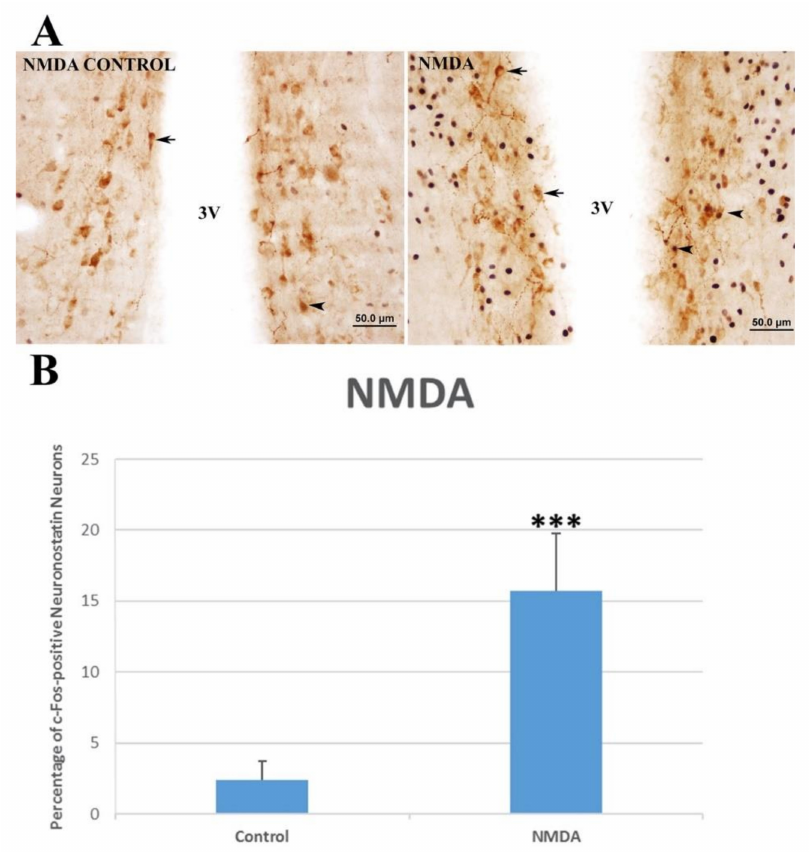
Brain Sci. 2020 , 10 , x FOR PEER REVIEW 7 of 14 neuronostatin neurons after 48 h fasting (on the left), pSTAT5 expression in neuronostatin neurons activated with refeeding in anterior hypothalamic periventricular nucleus (in the middle), neuronostatin neurons in the anterior periventricular nucleus in CNQX-treated subjects before Figure 6. The e ff ect of NMDA administration on c-Fos expression in neuronostatin neurons located in feeding (on the right) ( A ). pSTAT5 protein-expressing neuronostatin neurons ( ▲ ) and pSTAT5- the anterior hypothalamic periventricular nucleus. c-Fos protein-expressing neuronostatin neurons ( (cid:78) ) negative neuronostatin neurons (  ). 3V: third and c-Fos-negative neuronostatin neurons (